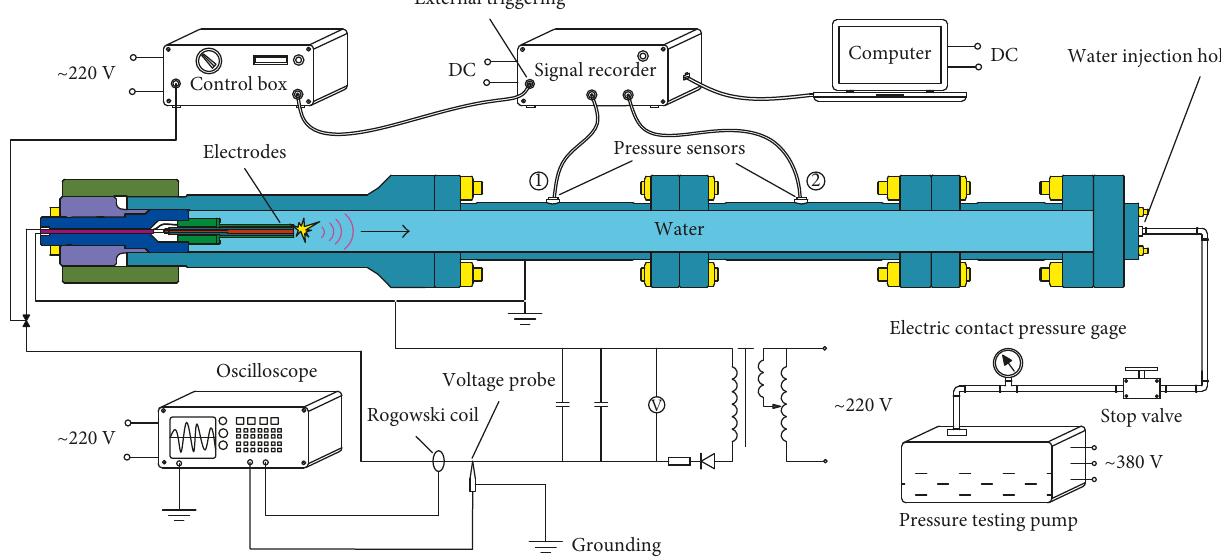
Figure 1: Schematic diagram of the experimental